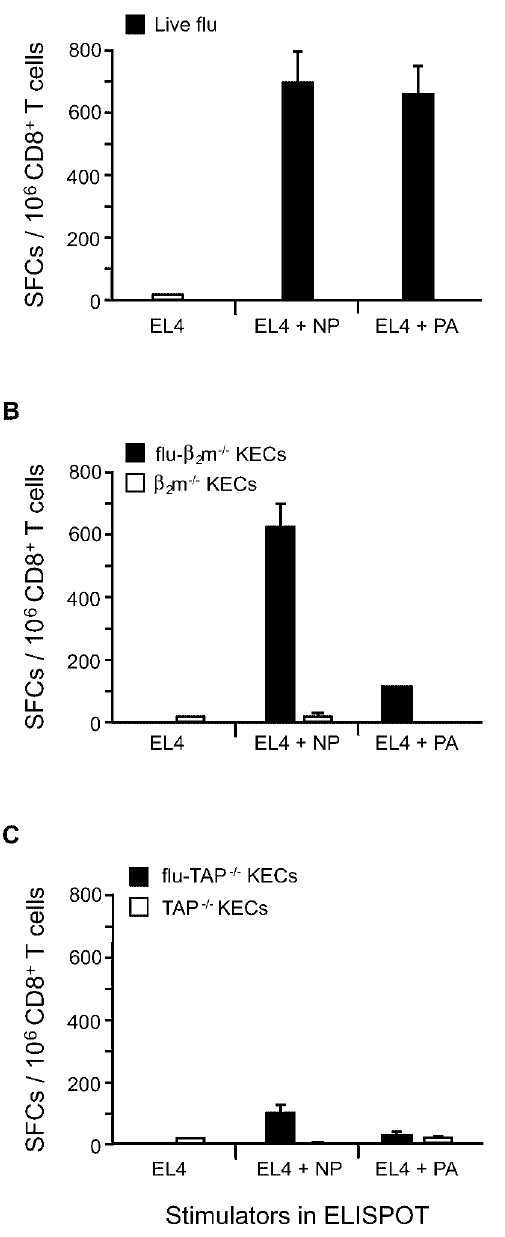
Figure 5. Processed Antigen within the Dying Cell Is Required for Efficient In Vivo Priming C57BL/6 mice were immunized intraperitoneally with 300 HAU of influenza (A), or 2 3 10 6 infected apoptotic kidney epithelial cells derived from b 2 m-deficient (B) or TAP-deficient mice (C). After 14 d, splenocytes were harvested, and CD8 þ T cells were purified. To assay for the specificity of these cells, an IFN- c ELISPOT was performed using the following stimulators: EL4 cells alone or EL4 cells pulsed with either 1 l M NP 366–374 or 1 l M PA 224–233 peptide. Values are averages of triplicate wells with error bars indicating standard deviation. DOI: